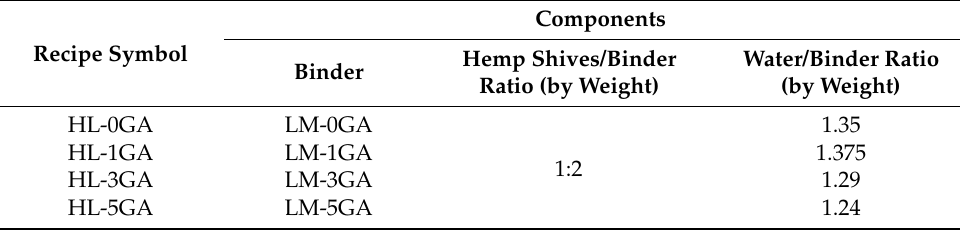
Table 3. Components of the tested hemp-lime